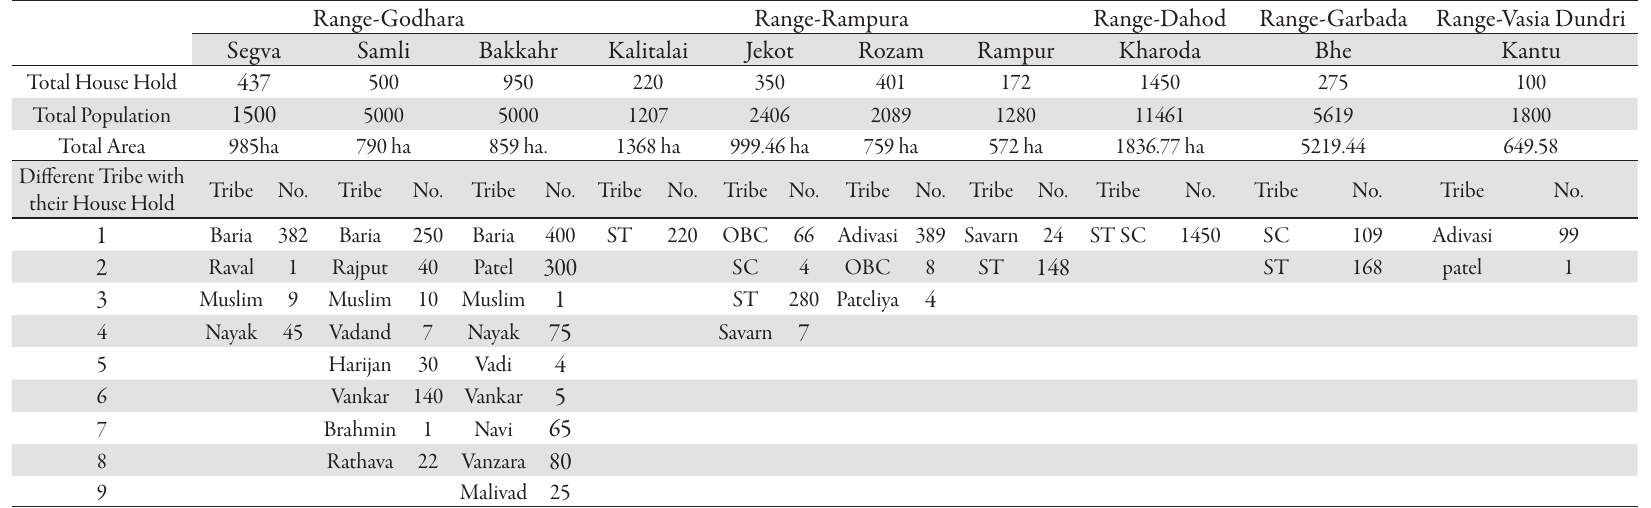
Tab. 1. Distribution of the different tribes in the selected villages